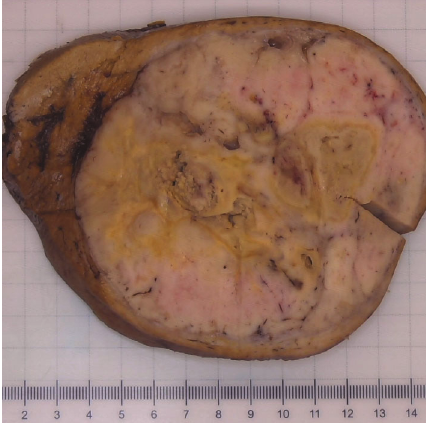
Figure 1: Contrast-enhanced abdominal computed tomography (CT) showed a large well-circumscribed mass in the lateral segment of the left hepatic lobe with early arterial phase enhancement.